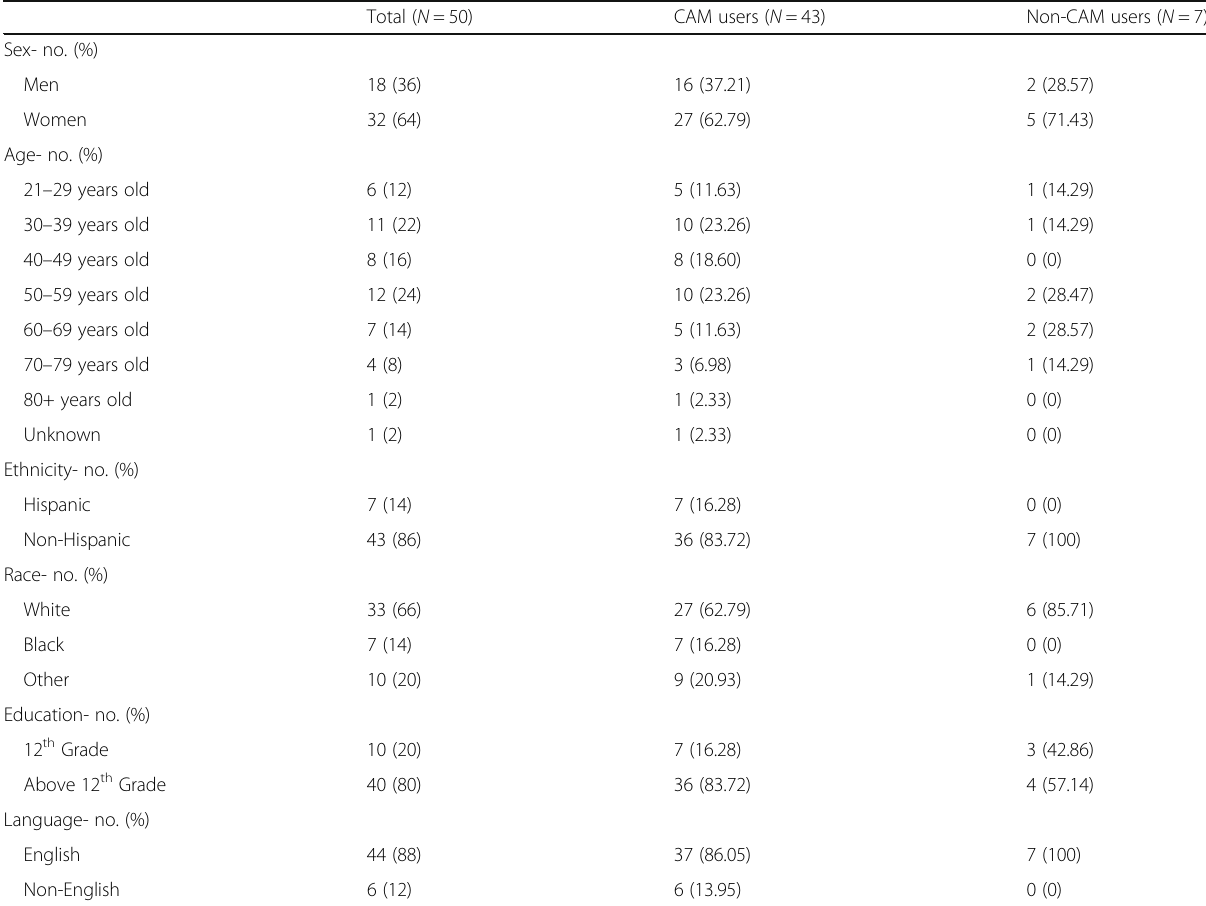
Table 1 Participant demographics by CAM use